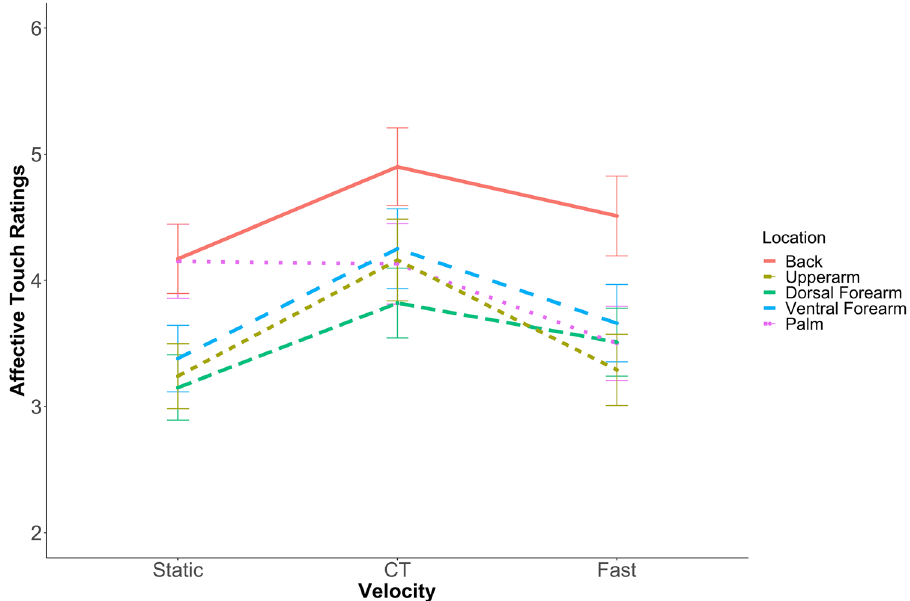
Figure 3. Data show the established quadratic relationship between affective ratings and velocity of touch on the dorsal and ventral forearm, upper arm and back. Here slow, CT-optimal (~ 3 cm/s) touch was rated more positively than static and fast (~ 30 cm/s) touch. In contrast, on the palm, static touch is rated equally positively to slow, CT-optimal (~ 3 cm/s) touch (bars ± 95%